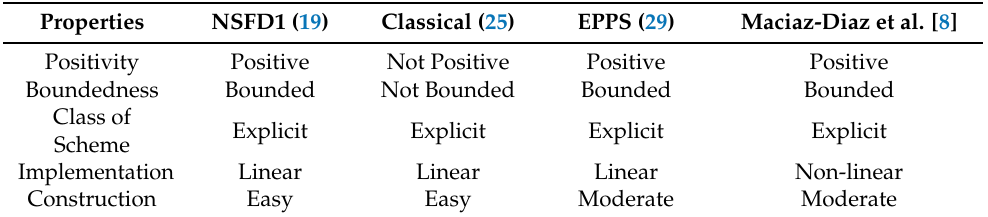
Table 4. Comparison of some finite-difference methods used for the mathematical modelling of biofilm formation to simulate Equation